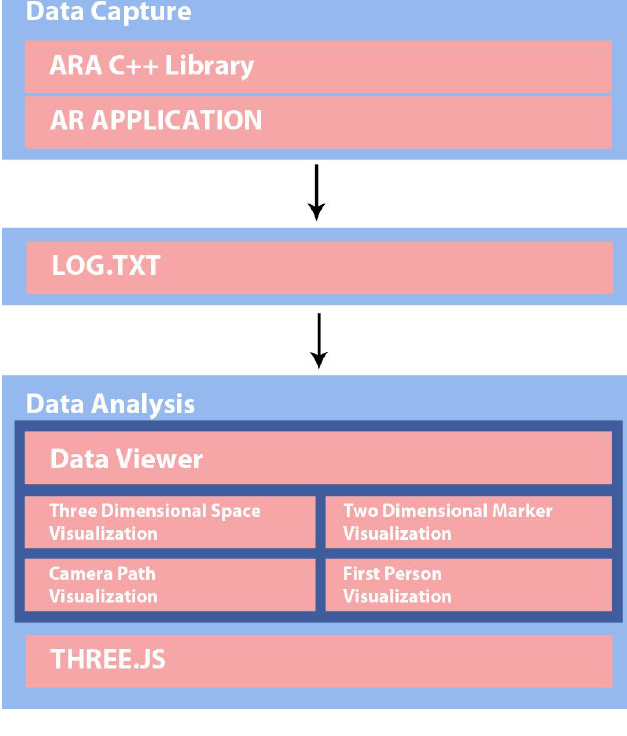
Figure 7. Framework overview.